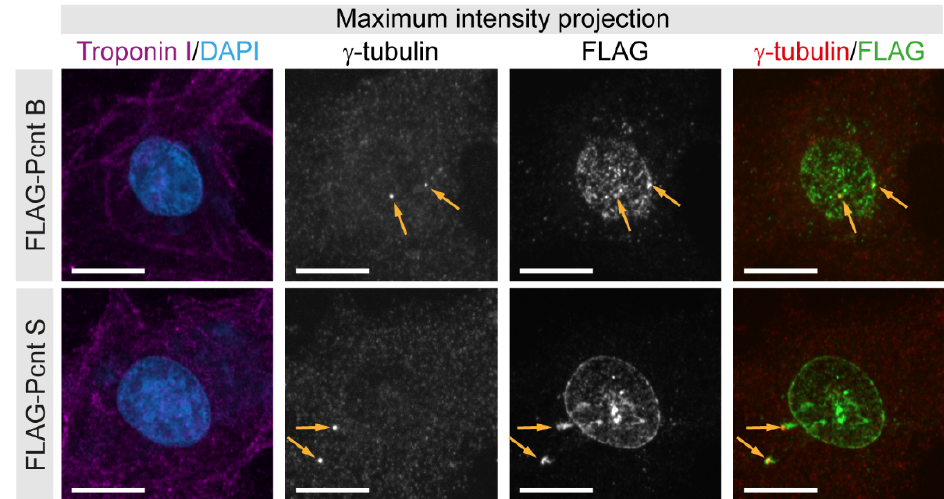
Figure 2. Localization of ectopically expressed Pcnt S and Pcnt B. FLAG-tagged Pcnt B (FLAG-Pcnt B) or Pcnt S (FLAG-Pcnt S) were expressed in P3 cardiomyocytes (troponin I) and their localization was assessed by staining for FLAG as well as centrioles/centrosome ( γ -tubulin). Nuclei were visualized with DAPI (DNA). Orange arrows: centrioles/centrosomes. Scale bars: 10 µm.